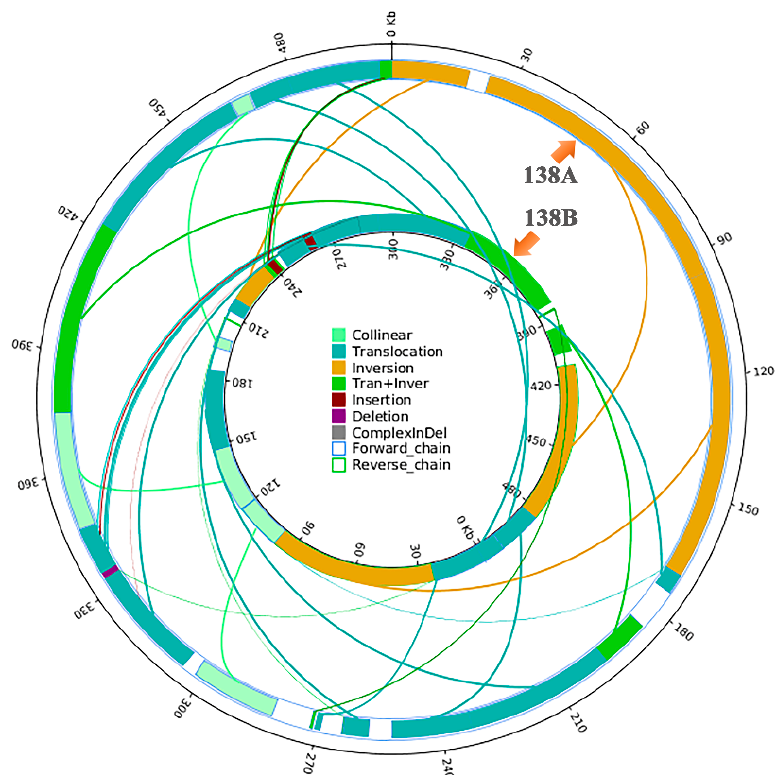
Figure 3. Structural variation map of mitochondrial genomes of 138A and 138B. The inner circle is the 138B genome, and the outer circle is the 138A genome. Collinear: the same linear region; Translocation: the area of translocation; Inversion: the area of inversion; Tran + Inver: the area of translocation and inversion; Insertion: the insertion region with a length greater than or equal to 50 bp; Deletion: the deletion region with length greater than or equal to 50 bp; Complex InDel: an area that cannot be compared, but corresponds to a position; Forward_chain: forward chain of the genome sequence, at which time the gene coordinates increase in a clockwise direction; Reverse_chain: the reverse chain of the genome sequence in which the genetic coordinates increase